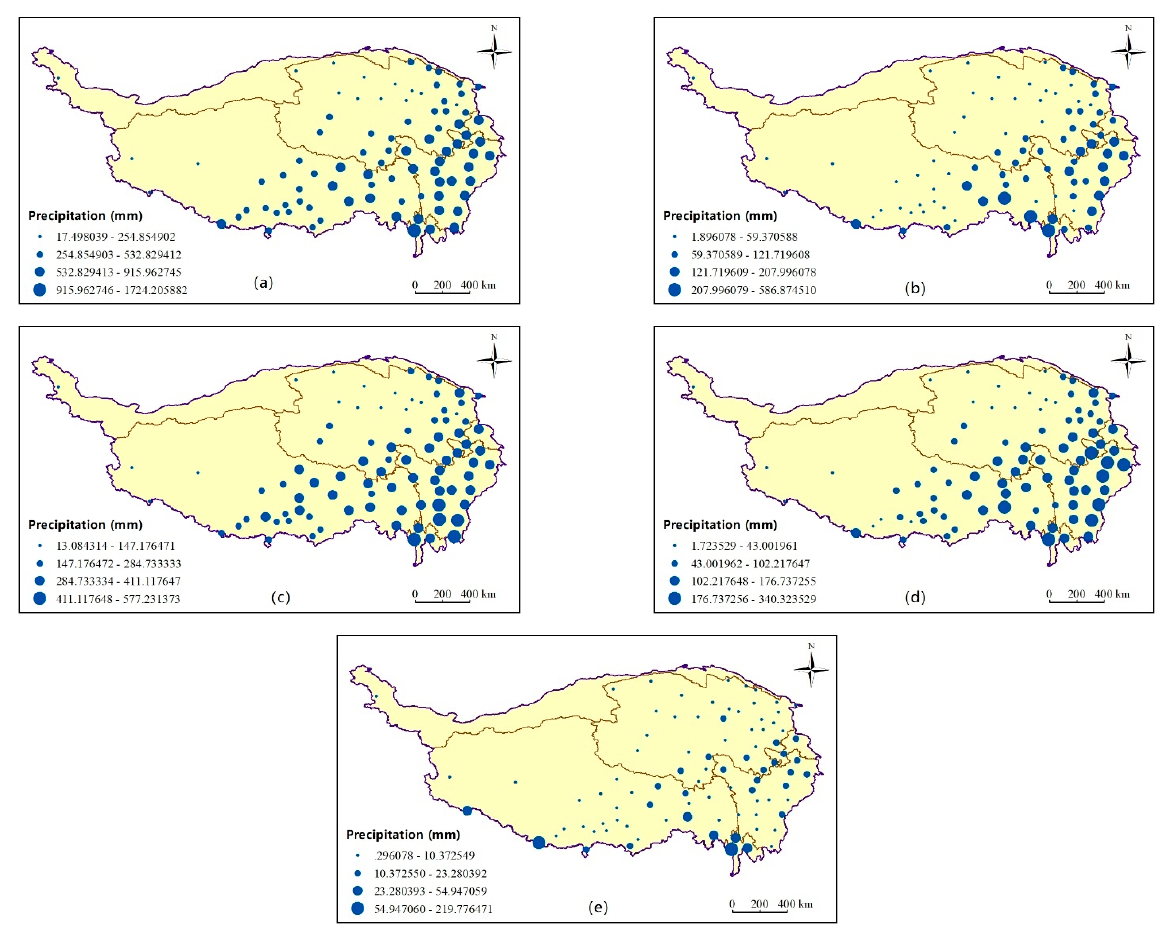
Figure 3. Spatial distribution of the multiyear average precipitation on the TP in 1966–2016. ( a ) Annual, ( b ) spring, ( c ) summer, ( d ) autumn, ( e ) winter.